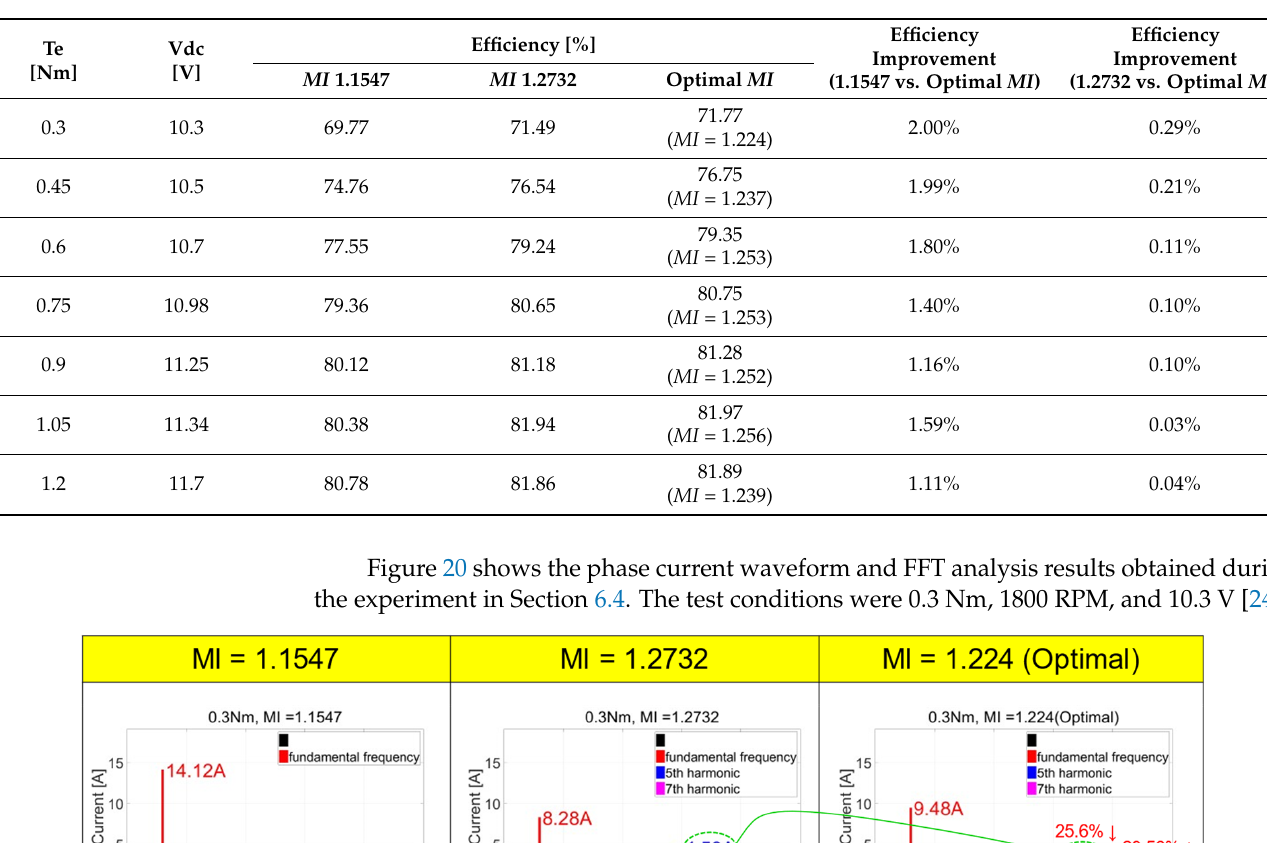
Table 1. Efficiency comparison results of optimal MI and fixed MI .